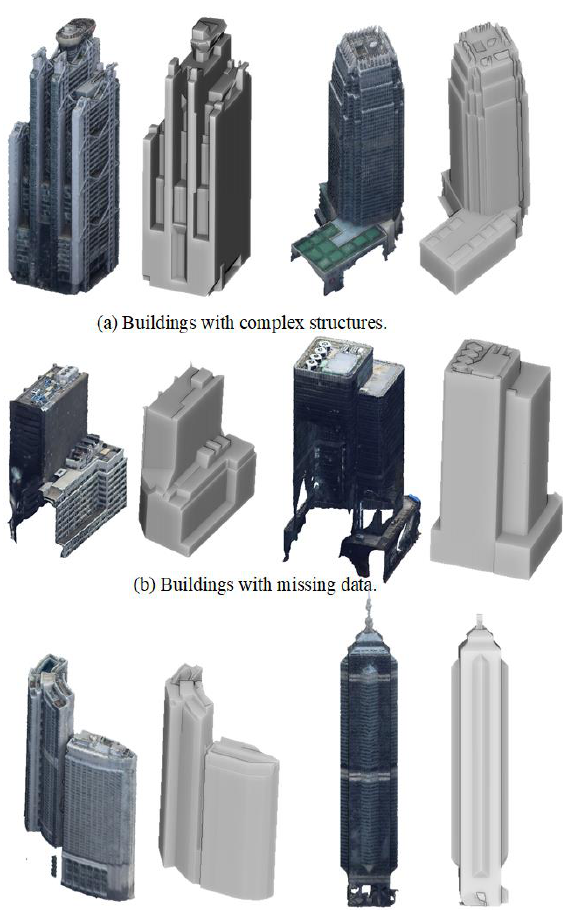
Figure 8. Reconstruction results of four challenging types of